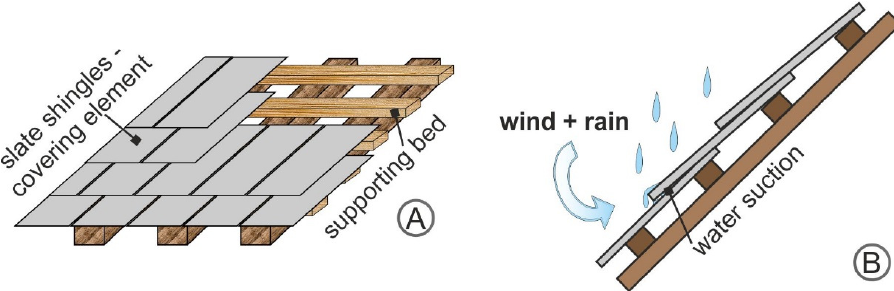
Figure 2. ( A ) diagram of a typical slate roof. ( B ) rainwater, propelled by the wind, penetrates between slate shingles.